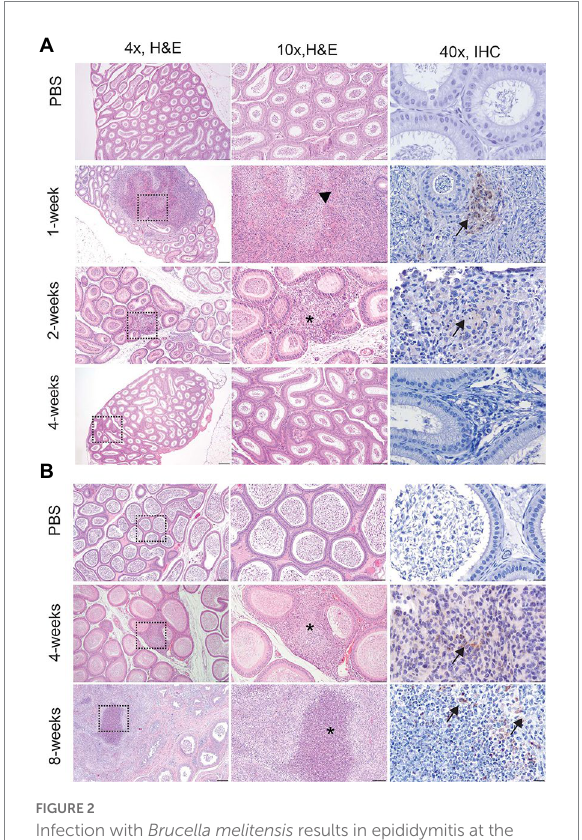
FIGURE 2 Infection with Brucella melitensis results in epididymitis at the peracute stage of infection in mice and the acute and chronic stages in guinea pigs. Mice (A) and guinea pigs (B) were inoculated with 10 7 B. melitensis via IT inoculation, and the epididymis was collected for histology. Representative images for the mouse (A) at the peracute (1- and 2-week p.i.) and acute (4-week p.i.) and guinea pig (B) at the acute (4-week p.i.) and chronic (8-weeks p.i.) stages of infection. A single mouse had rupture of the epididymal duct with intense inflammatory infiltrate (arrowhead). Macrophages in this region had abundant intracytoplasmic bacteria (IHC, arrows). The lesion in mice at 2-weeks and guinea pigs at 4-weeks consisted of a focally extensive infiltrate of histiocytes and neutrophils (*) in the interstitium of the epididymal duct. Scant macrophages were positive for Brucella antigen by IHC (arrows). By 8-weeks p.i., guinea pigs developed spermatic granulomas from rupture of the epididymal duct, and macrophages in the lesion contained abundant intracytoplasmic and extracellular Brucella antigen (IHC, arrows). Tissues were stained with hematoxylin and eosin (H&E) and a polyclonal Brucella antibody (IHC) at 1:500 with Gill’s hematoxylin counterstain. Dashed box of 4x image indicates area highlighted for the 10x and 40x images. 4x, scale bar = 100 μ m; 10x, scale bar = 50 μ m; 40x, scale bar = 10 μ m.